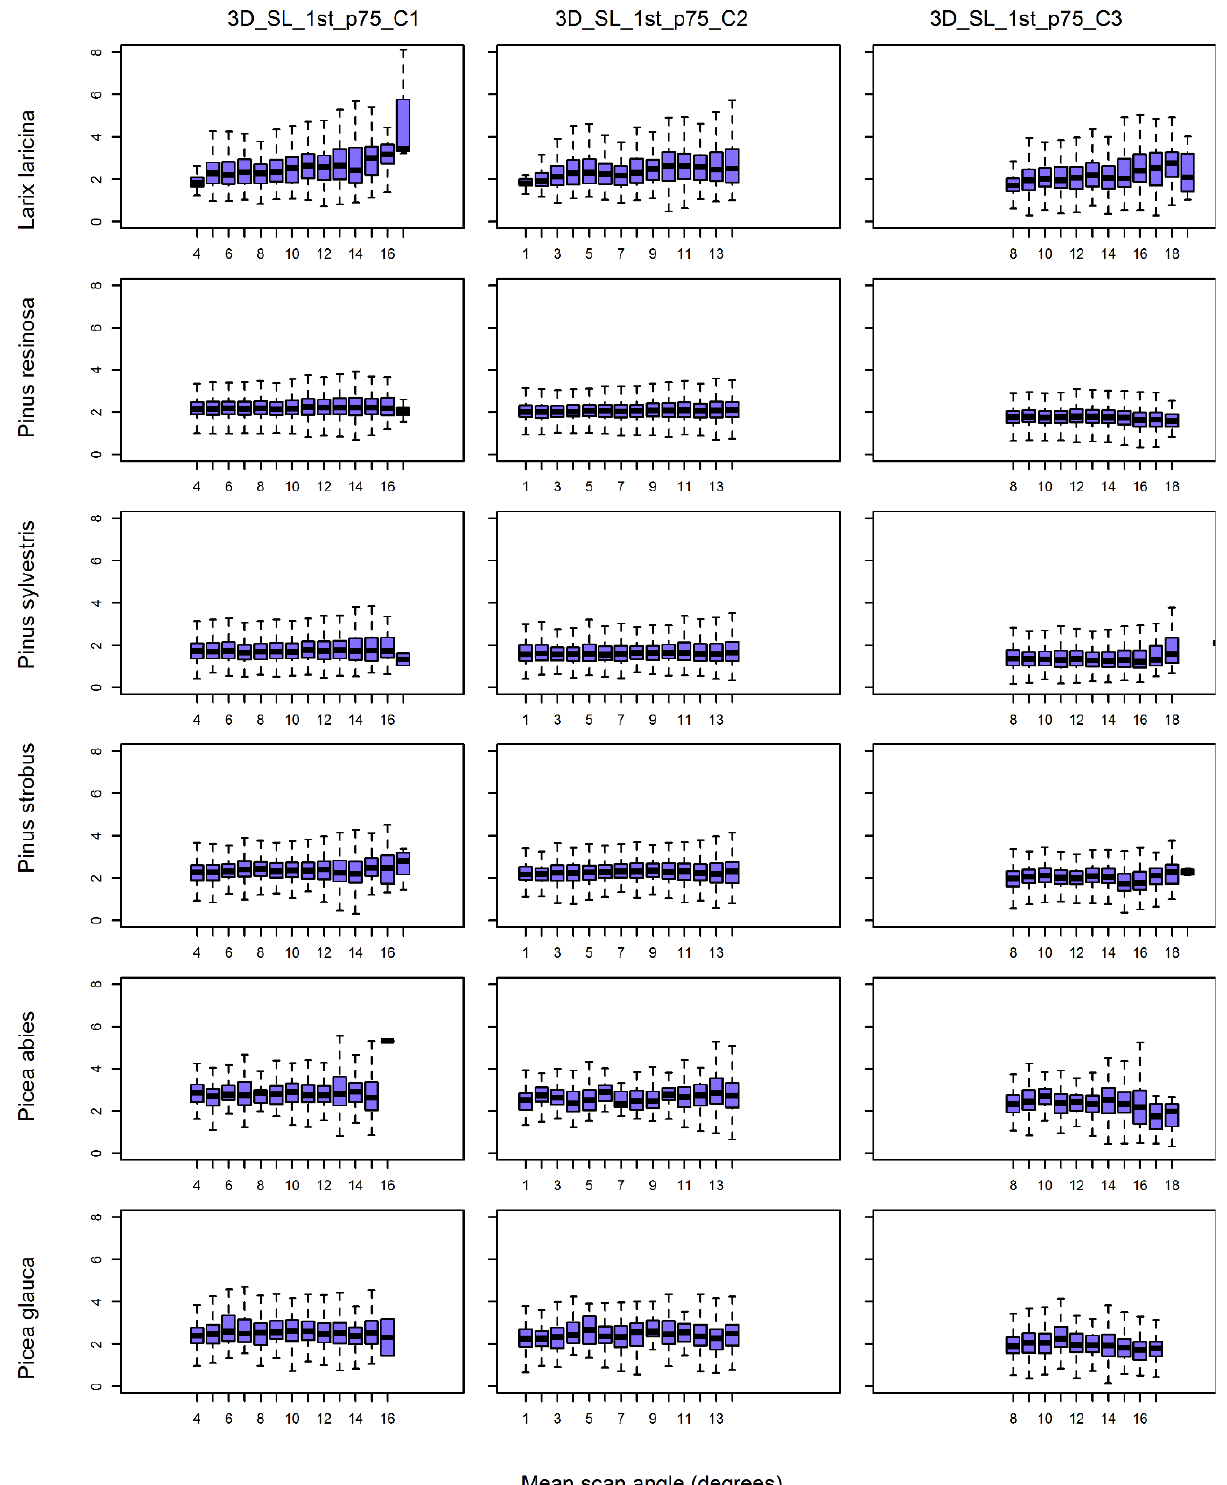
Figure 5. Variations in the feature 3D_SL_1st_p75 (75th percentile of the slope of the first returns in each of the three channels) according to scan angle, and per species.